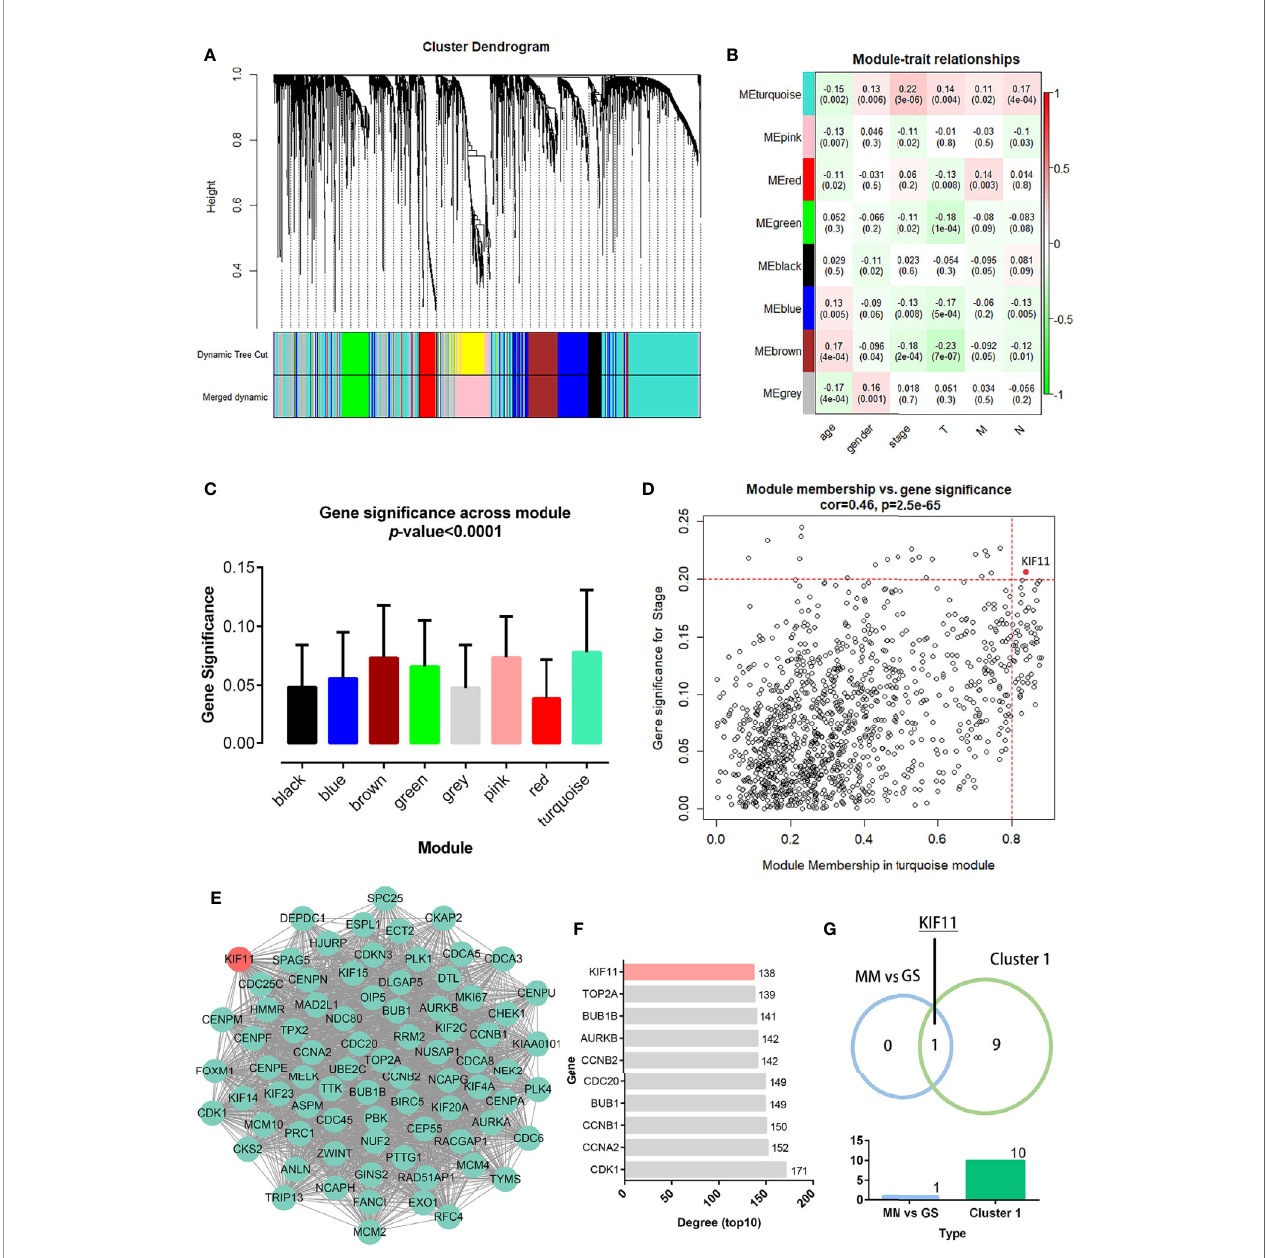
FIGURE 3 | Weighted co-expression gene network and protein-protein interaction (PPI) network. Clustering dendrogram of all DEGs based on a dissimilarity measure (1- TOM) (A) . Heatmap of the correlation between the modules and clinical traits of LUAD (B) . Distribution of the average gene signi fi cance and errors in modules associated with tumor stage (C) . Scatter plot of the turquoise module eigengenes (D) . Module membership (MM) >0.8 and gene signi fi cance for stage (GS) >0.2 were set as the cutoff thresholds. The top clustering module from the PPI network of the turquoise module (E) . Histogram of the connectivity degrees of genes in the top cluster (top 10) (F) . KIF11 was codetermined as a hub gene by the module eigengenes and connectivity degrees in a scatter plot and histogram, respectively (G)